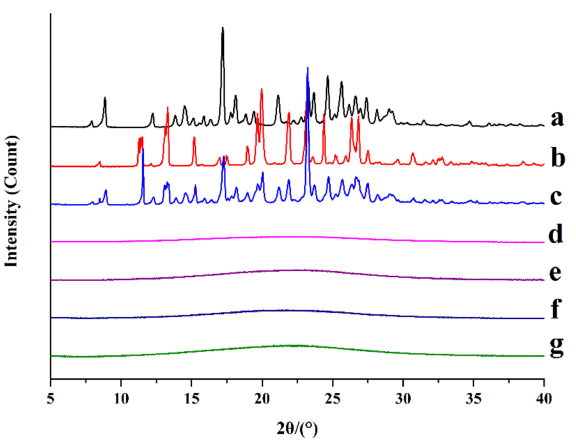
Figure 2. XRPD diffractograms: ( a ) crystalline CUR; ( b ) crystalline MAG; ( c ) CUR-MAG PM; ( d ) CUR-MAG CM; ( e ) CUR-MAG-HPMC CM; ( f ) CUR-MAG-HPC CM; ( g ) CUR-MAG-PVP K30